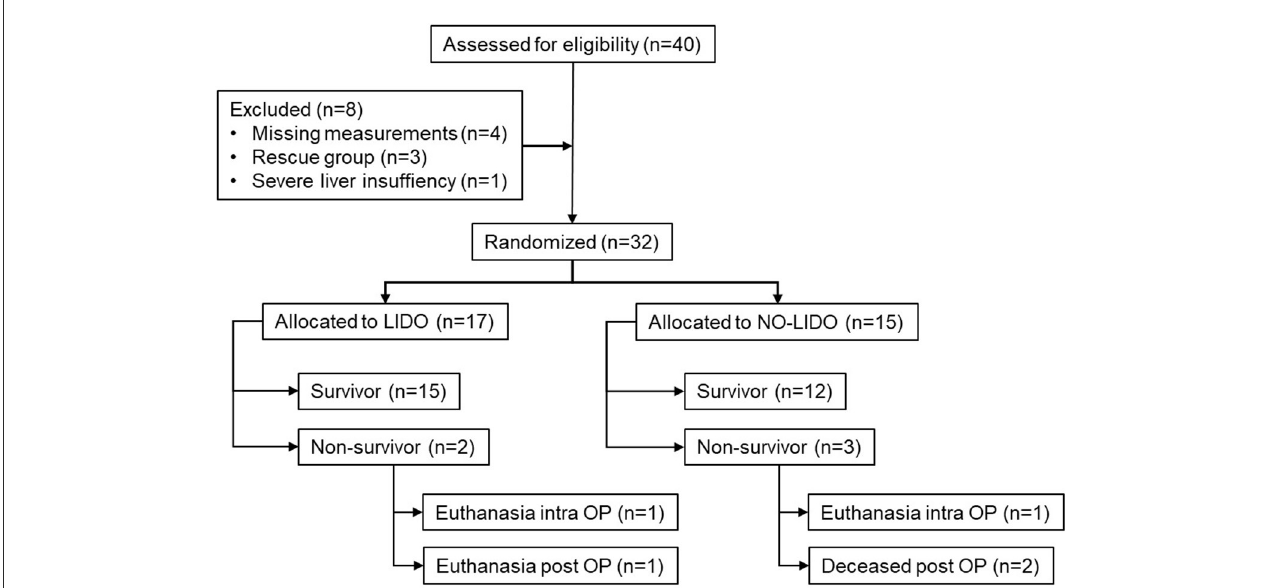
FIGURE1 Inclusion and exclusion of 40 dogs presented with GDV into the study cohort. LIDO, GDV dogs treated with lidocaine; NO-LIDO, GDV dogs treated without lidocaine; rescue group, dogs initially enrolled in the NO-LIDO group but needed lidocaine due ventricular tachycardia; intra OP, intra-operatively, post OP, post-operatively.